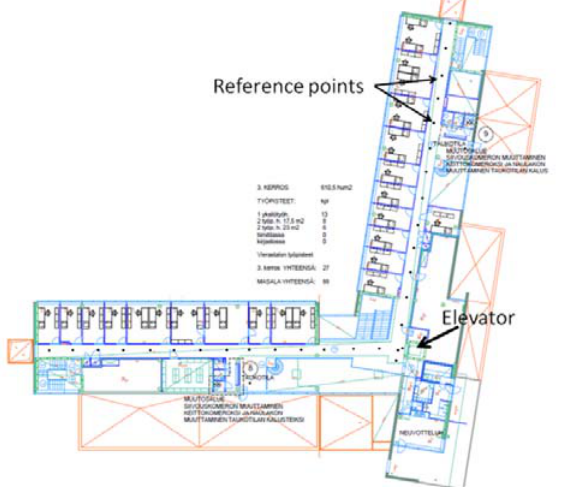
Figure 7. The layout and indoor environment of the experimental